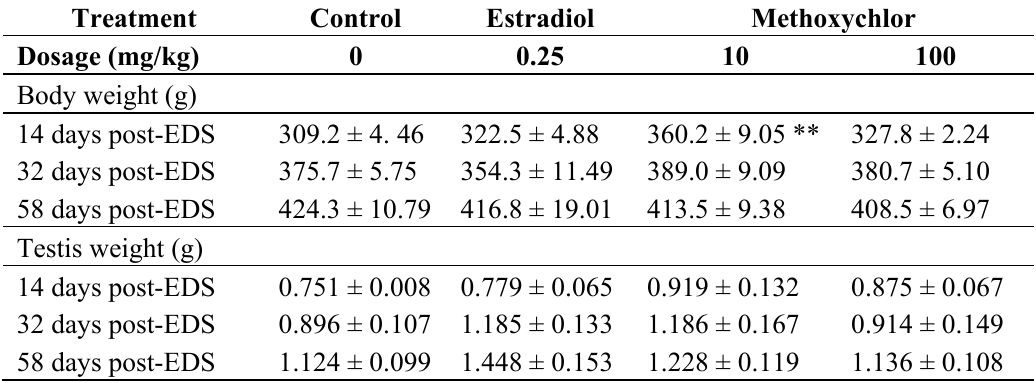
Table 1. General parameters of toxicology after treatment of methoxychlor. EDS, ethane dimethane